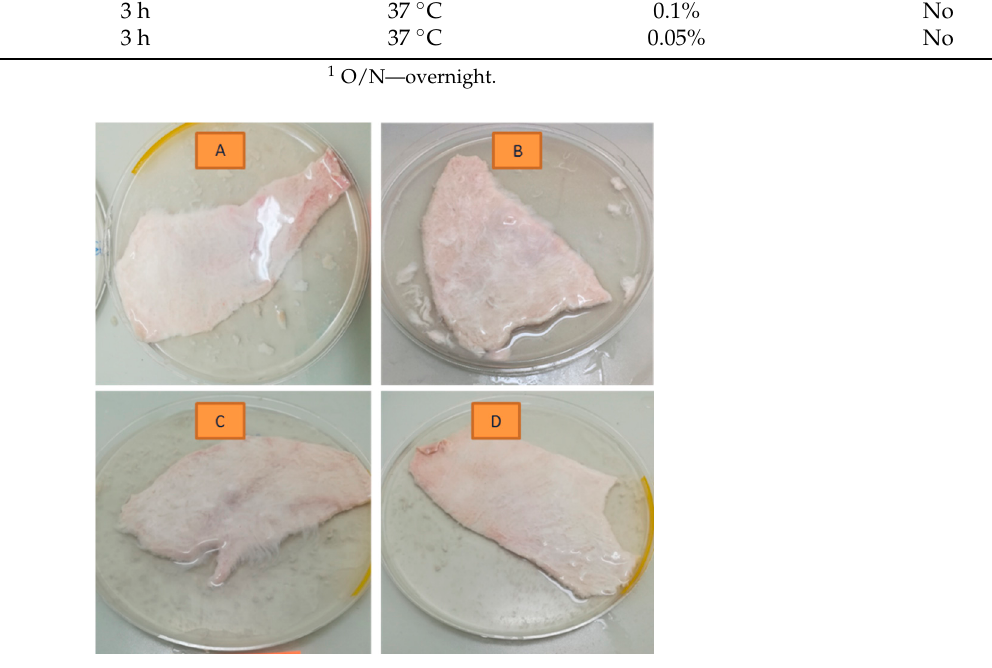
Figure 1. Visual aspect of the skin portions subjected to the different experimental conditions, after the defined incubation time. ( A – D ) conditions are detailed in Table 1.